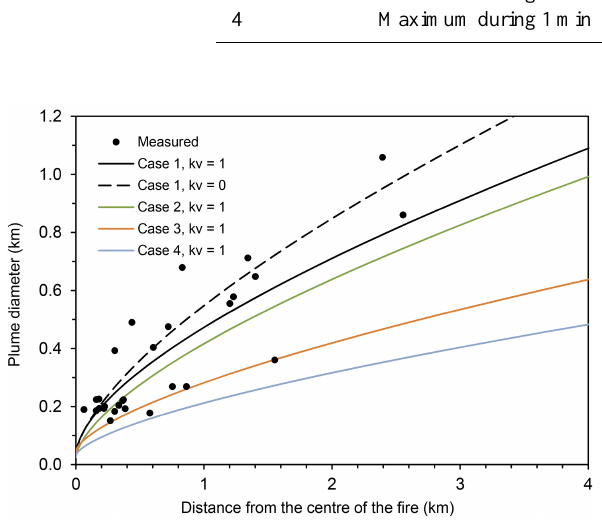
Figure 7. The measured and predicted plume diameters against downwind distance from the centre of the fire for cases 1–4. The data of measurements are presented as black dots, and predictions as solid and dashed